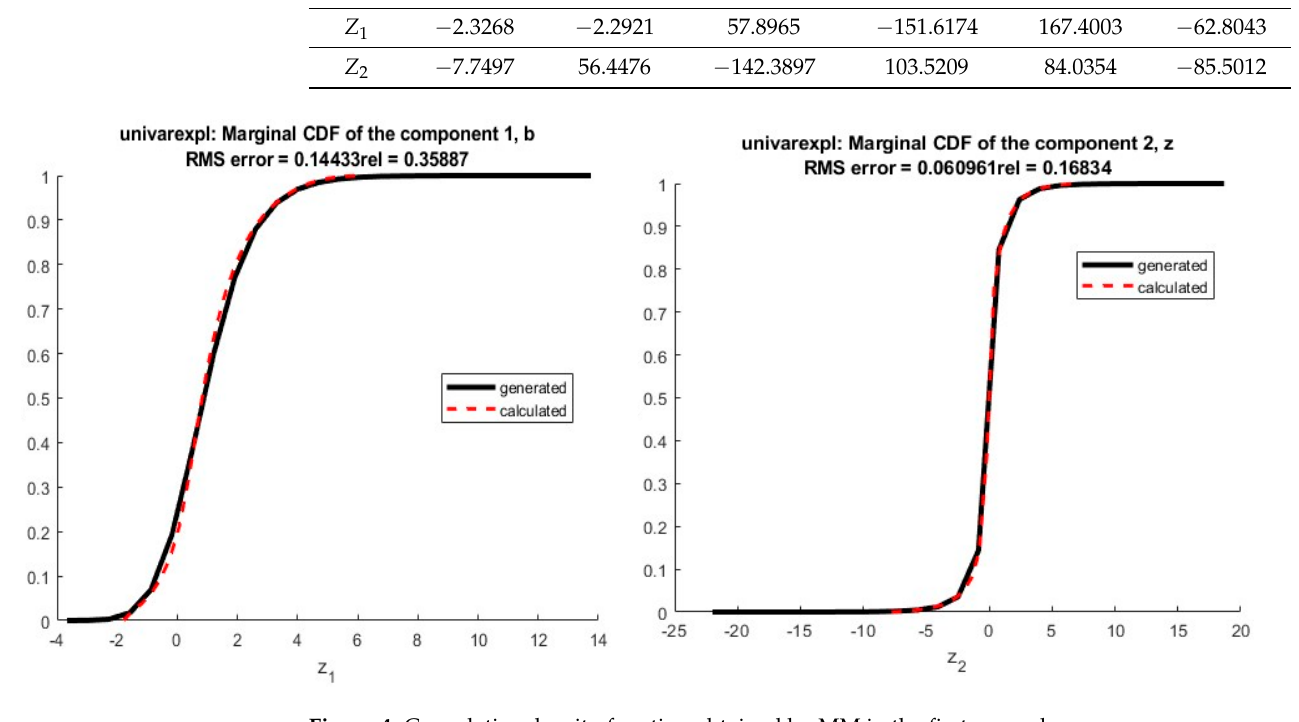
Table 5. Coefficients found in the second example by MM.